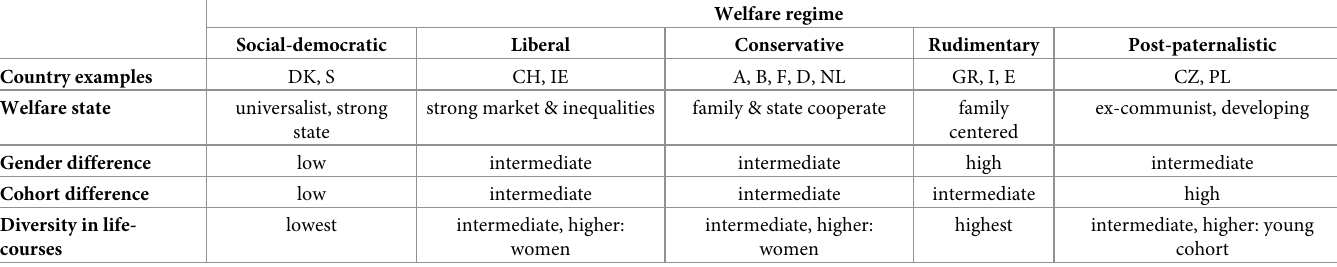
Table 1. Welfare regimes and working age